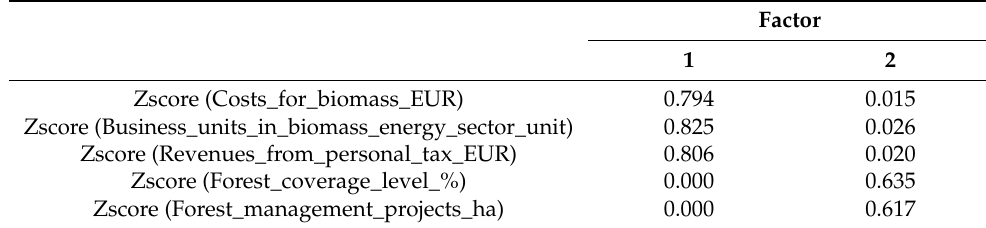
Table 7. Importance results of the biomass energy sector